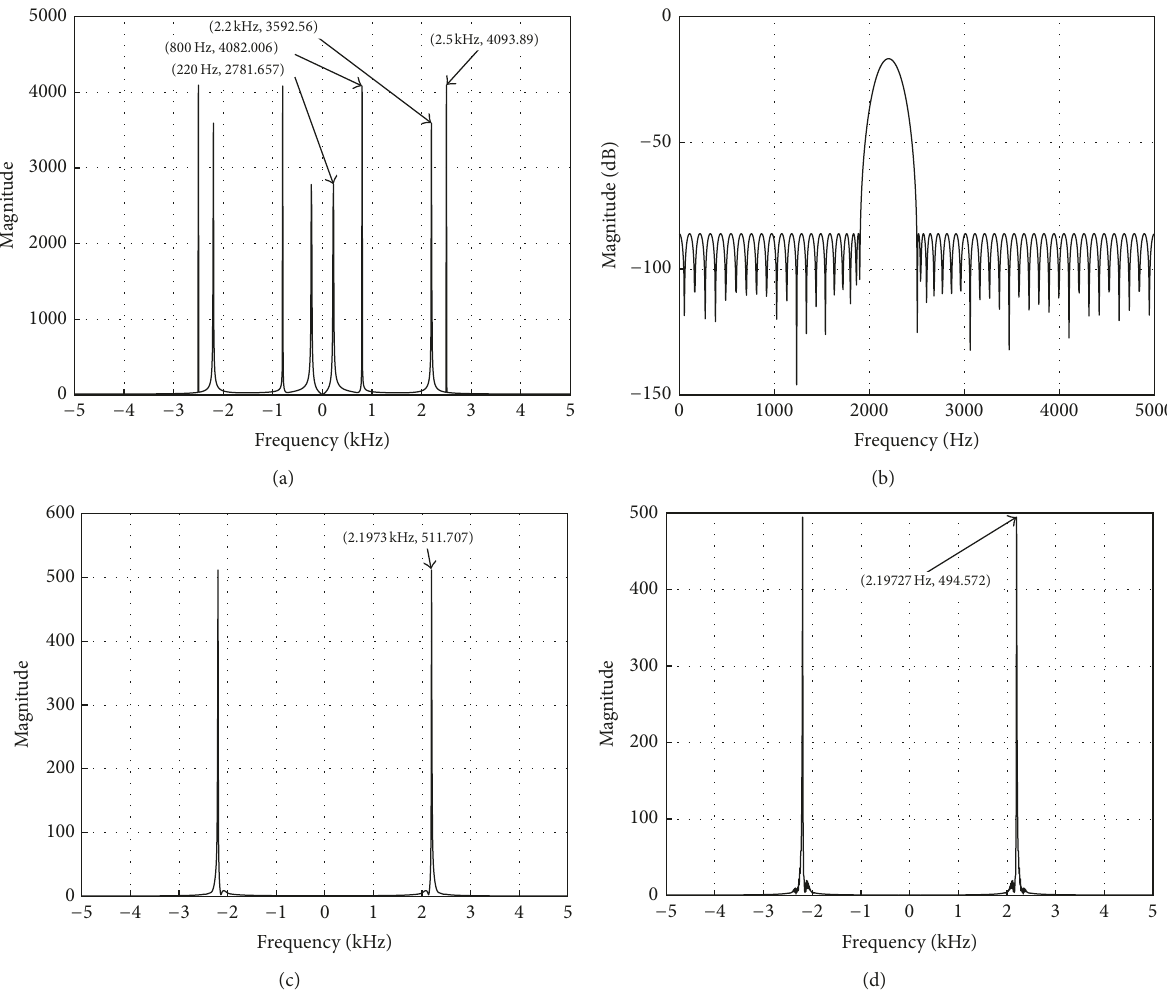
Figure 14: The results of FIR filter testbench. (a) Magnitude spectrum of input signal. (b) FIR filter frequency response (filter response parameters: sampling frequency = 10 kHz , lower cutoff frequency = 2.190kHz , higher cutoff frequency = 22.15 kHz , passband ripple = 3 dB , stopband attenuation = 80 dB , and number of coefficients = 95 ). (c) Magnitude spectrum of Matlab FIR filter output. (d) Magnitude spectrum of FPGA FIR filter